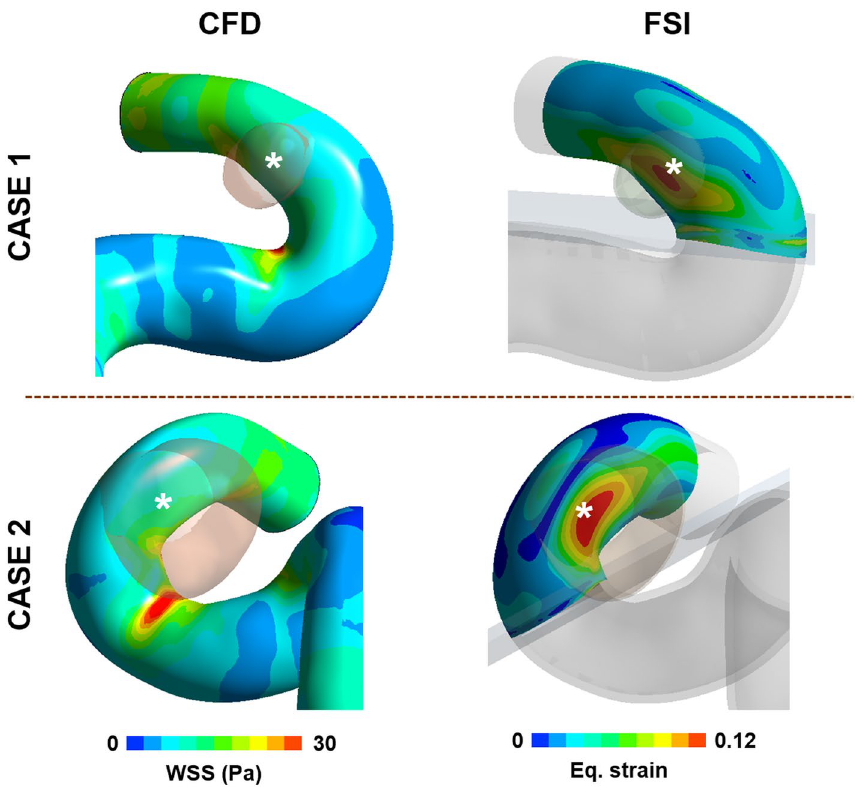
Figure 4. Examples where location of the aneurysm formation site is clear in correlation with high strain but not with high WSS. The location of high WSS and high strain was extracted from results of CFD and FSI analysis at the systolic time. A white star (*) indicates the location of aneurysm formation site.